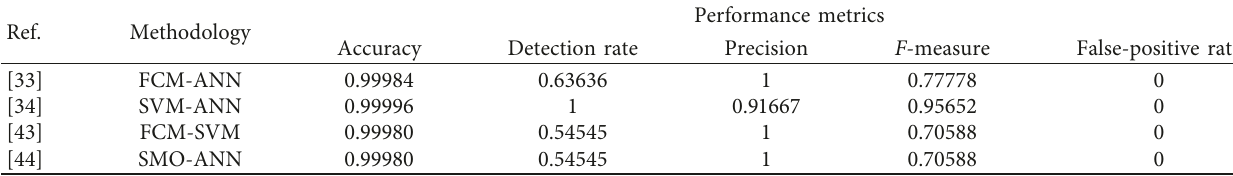
Table 17: Comparison of various methodologies based on different performance metrics for user-to-root (U2R) attack. Ref.